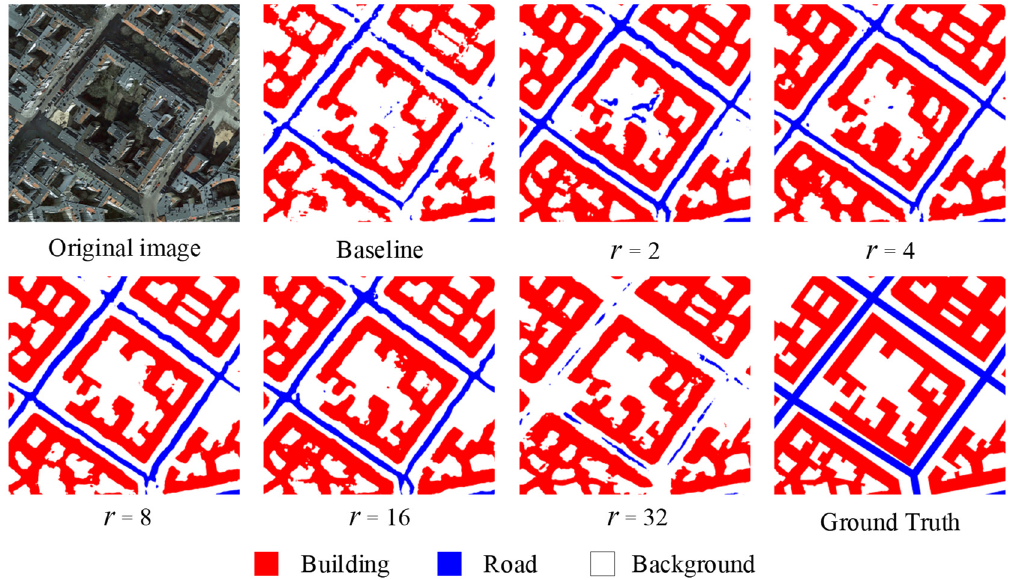
Figure 9. Comparison of visual results of dimensionality reduction based on the CITY-OSM da- taset.